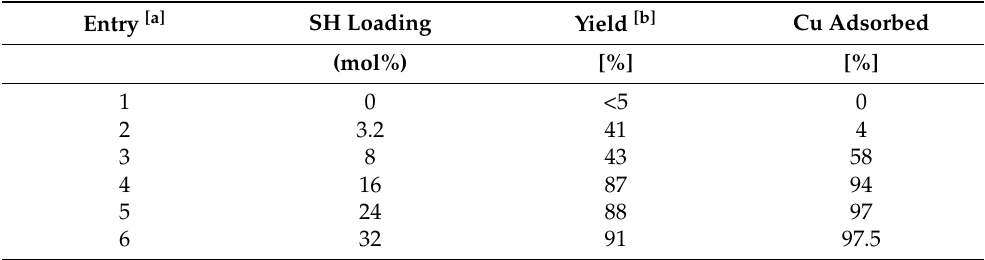
Table 2. The adsorption properties of Cel–SH for the copper-catalyzed (cellulose supported Cu 2 O) Huisgen 1,3-dipolar cycloaddition of azide with the terminal alkyne forming